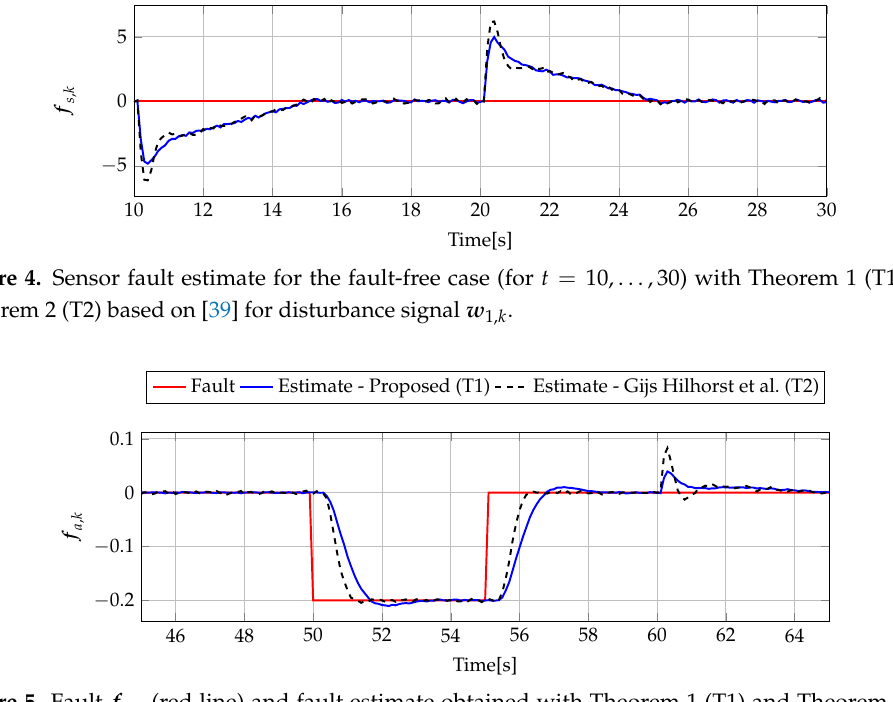
Figure 5. Fault f (red line) and fault estimate obtained with Theorem 1 (T1) and Theorem 2 (T2) a , k based on [39] for FS1 (for t = 45, . . . ,65 [ s ] ) as well as the response for disturbance signal w 1, k .